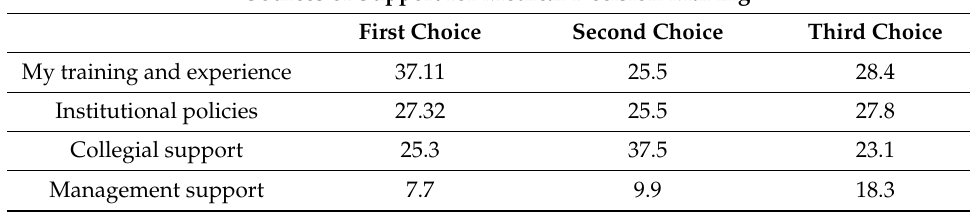
Table 3. Factors that most supported respondents’ decision-making during the pandemic (up to 3 choices allowed).